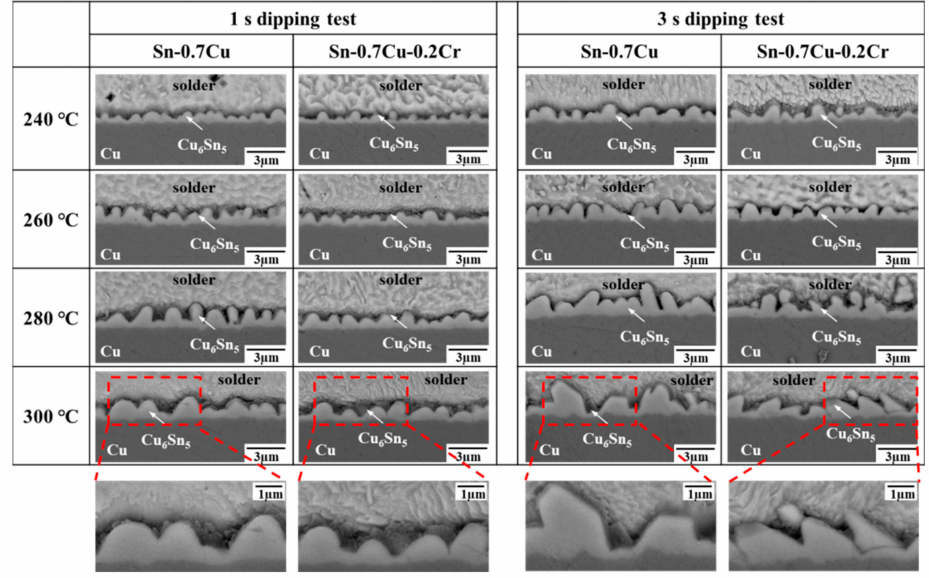
Figure 5. Cross-sectional images of the Cu 6 Sn 5 IMCs obtained after dipping the Cu coupon in Sn-0.7Cu and Sn- 0.7Cu-0.2Cr solders at various reaction temperatures.